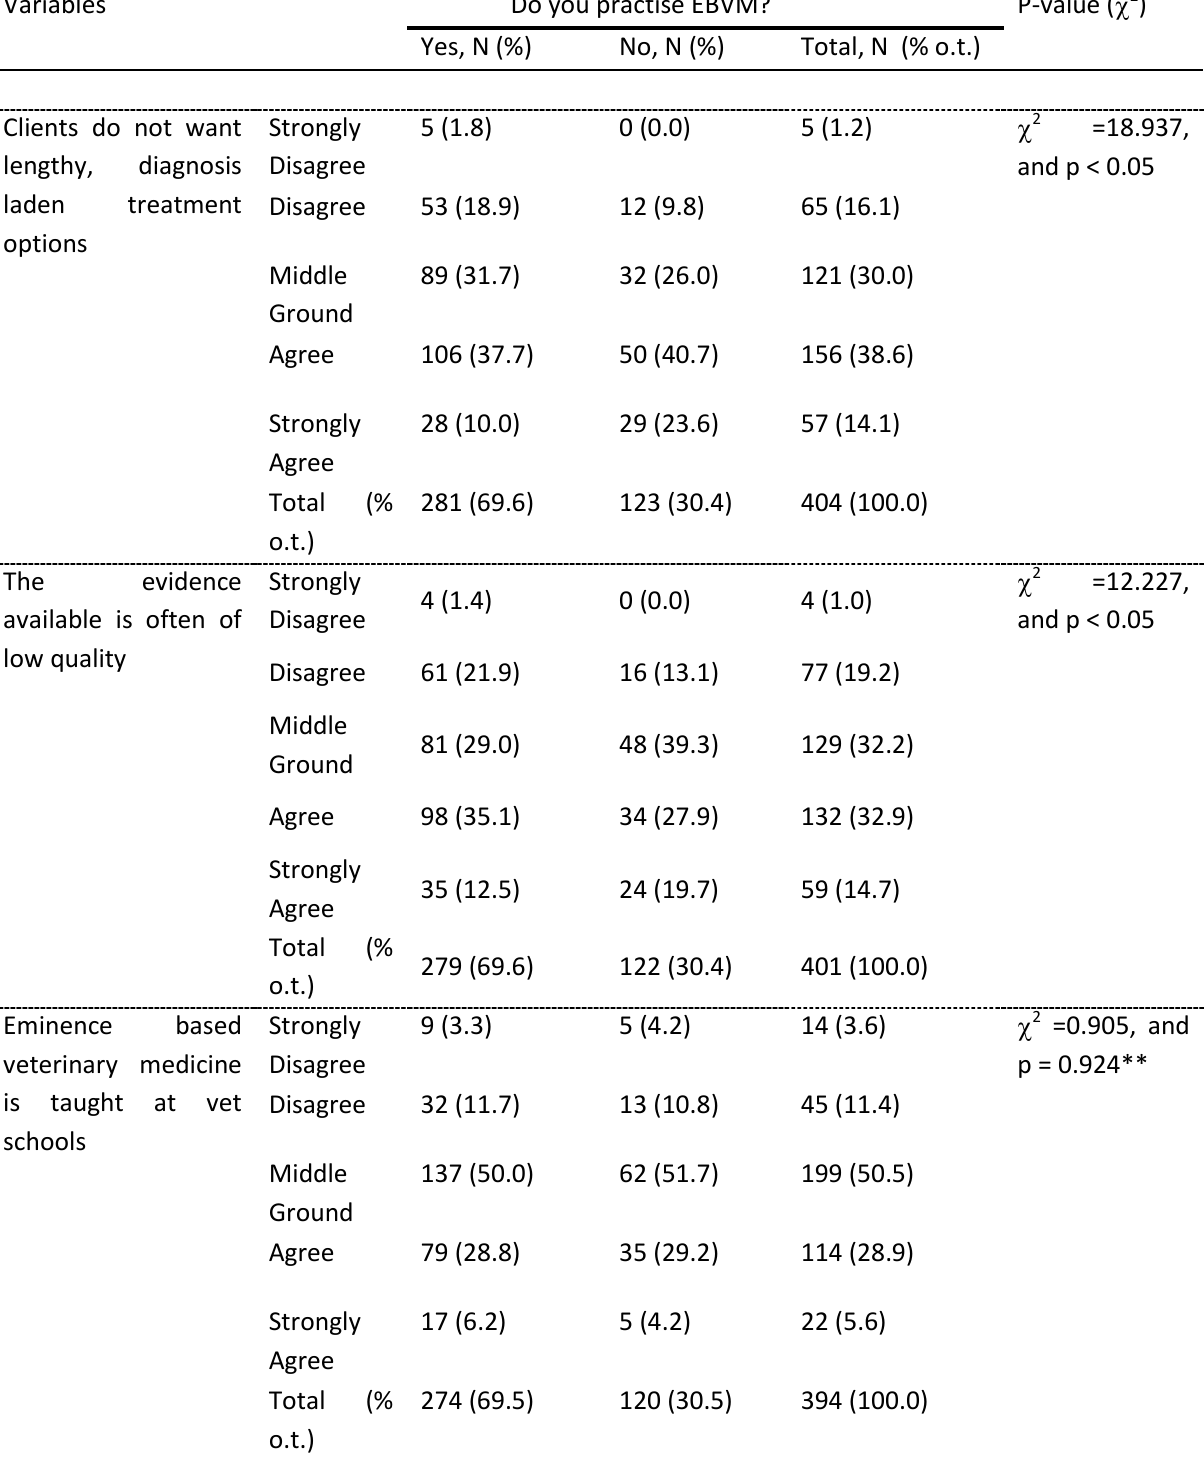
Table 9 : The barriers to EBVM II Variables Do you practise